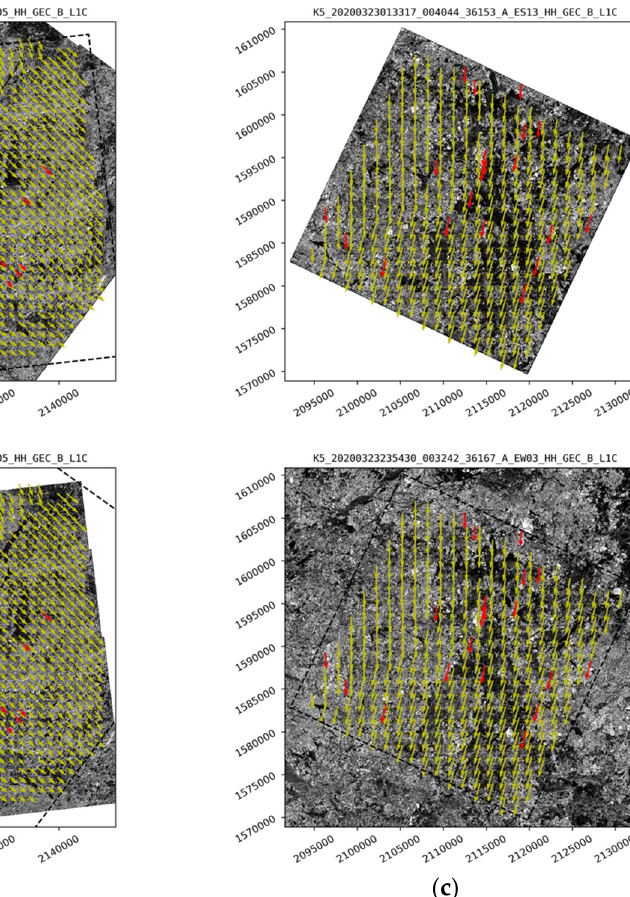
Figure 3. Drift vectors overlaid on the primary (top panels) and secondary (bottom panels) images of KOMPSAT-5: ( a ) Stripmap–Stripmap mode, ( b ) ScanSAR–ScanSAR mode, and ( c ) Stripmap–ScanSAR mode. Yellow and red arrows represent the results from pattern matching and SVP buoy record, respectively. Black dotted line indicates the footprint of paired image. Note that the pattern matching result vectors are not fully shown (1.5 km and 3 km spacing in ( a , c ) and ( b ) for display). The naming convention of K5 product is K5_<YYYYMMDDhhmmss>_<tttttt>_<nnnnn>_<o>_<MM><SS>_<PP>_<LLL>, which represent the sensing start time, processing offset, number of orbit, orbit direction, imaging mode, swath identifier, polarization, and processing level,